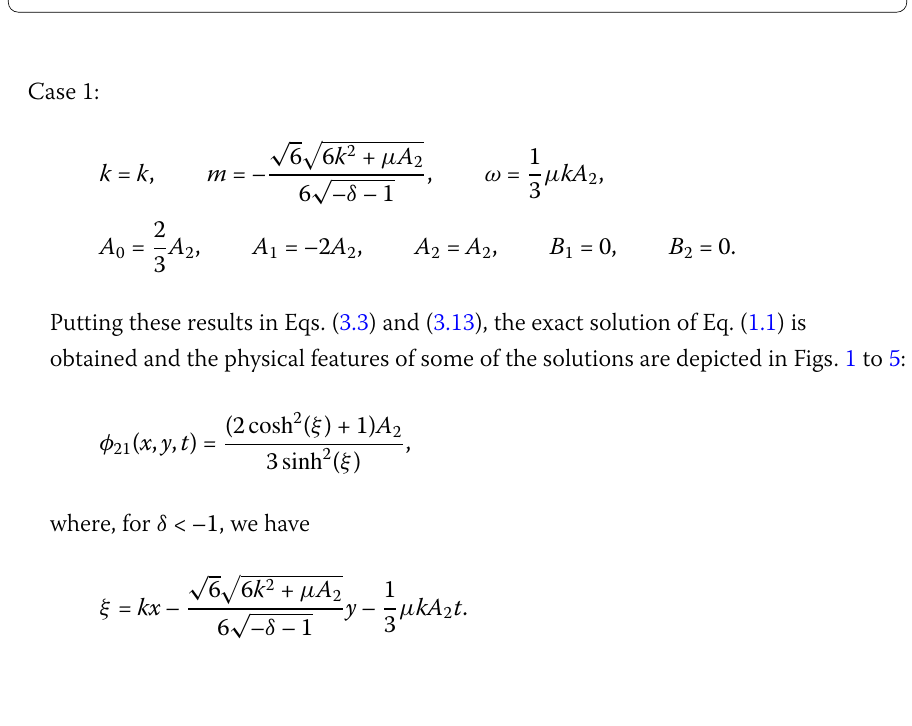
Figure 2 3D plot for φ 8 at y = 1 with B 2 = μ = δ = 1 and 2D at t =